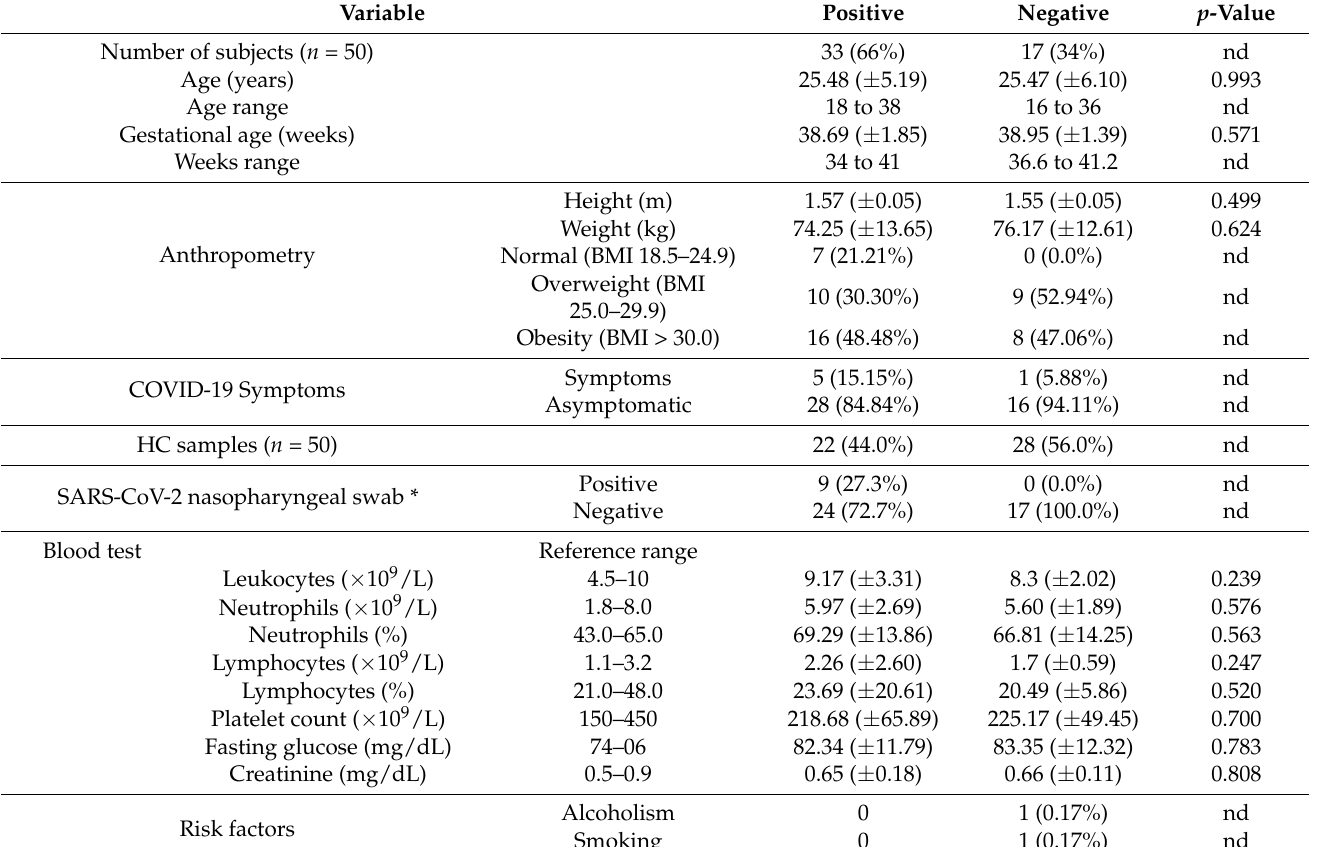
Table 1. Data of 50 participant mothers grouped according to SARS-CoV-2 rectal swab RT-ddPCR